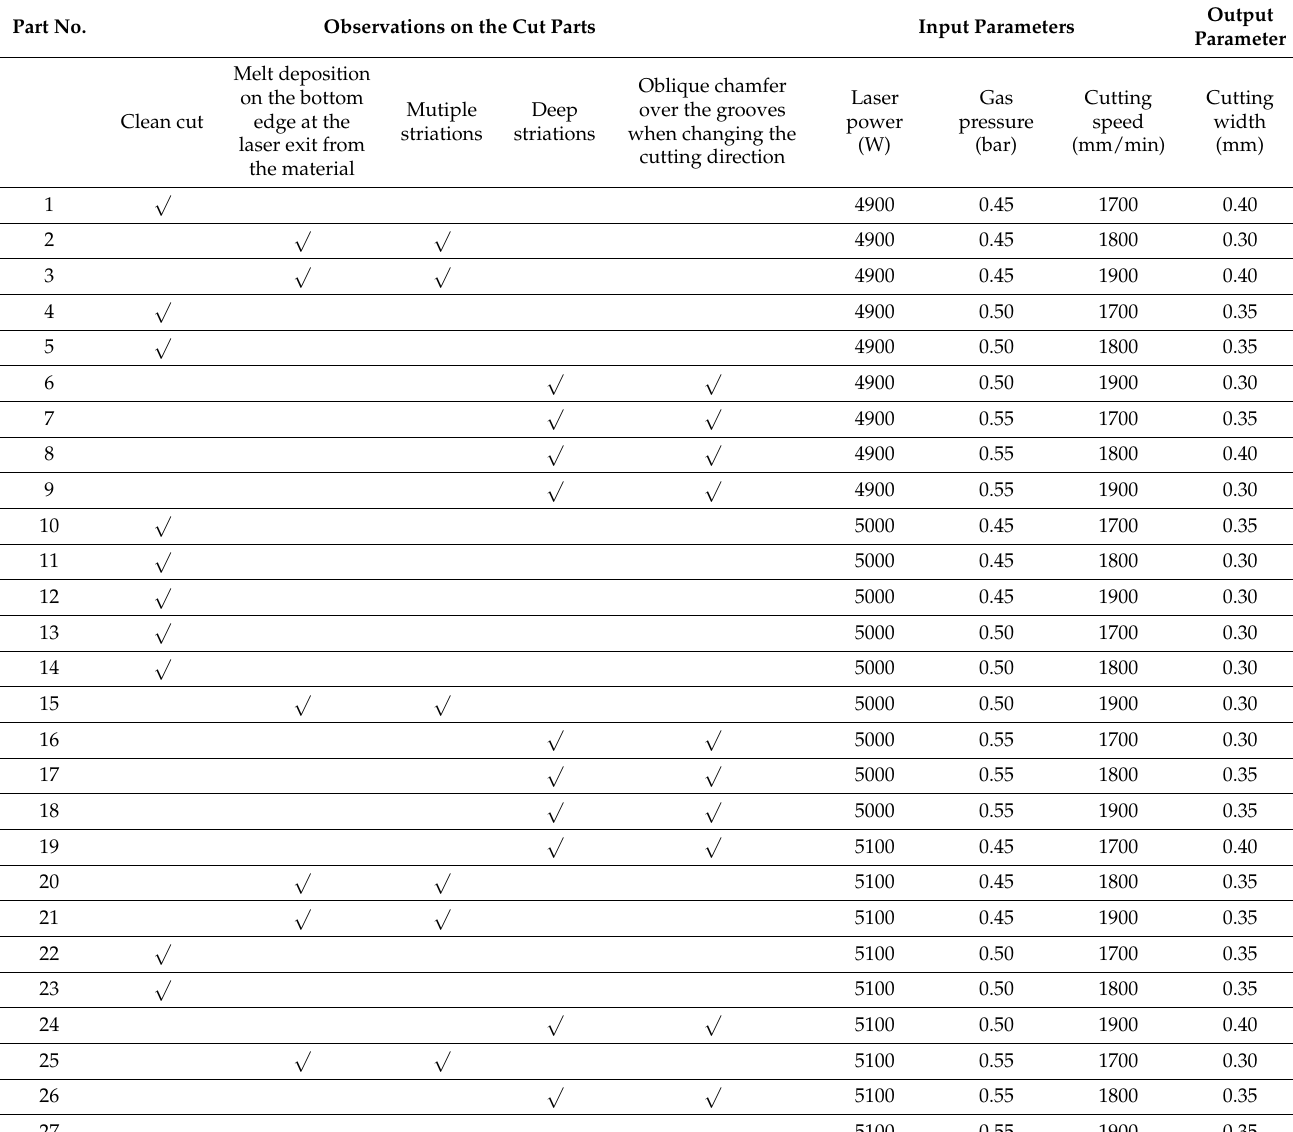
Table 3. Observations on the parts. Input and output parameter